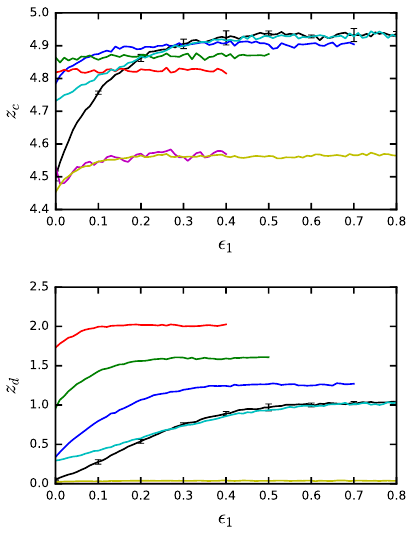
Figure 7. Contact coordination (top graph) and distant inter- action coordination number (bottom) versus axial strain. Same colour code as in Fig. 5.